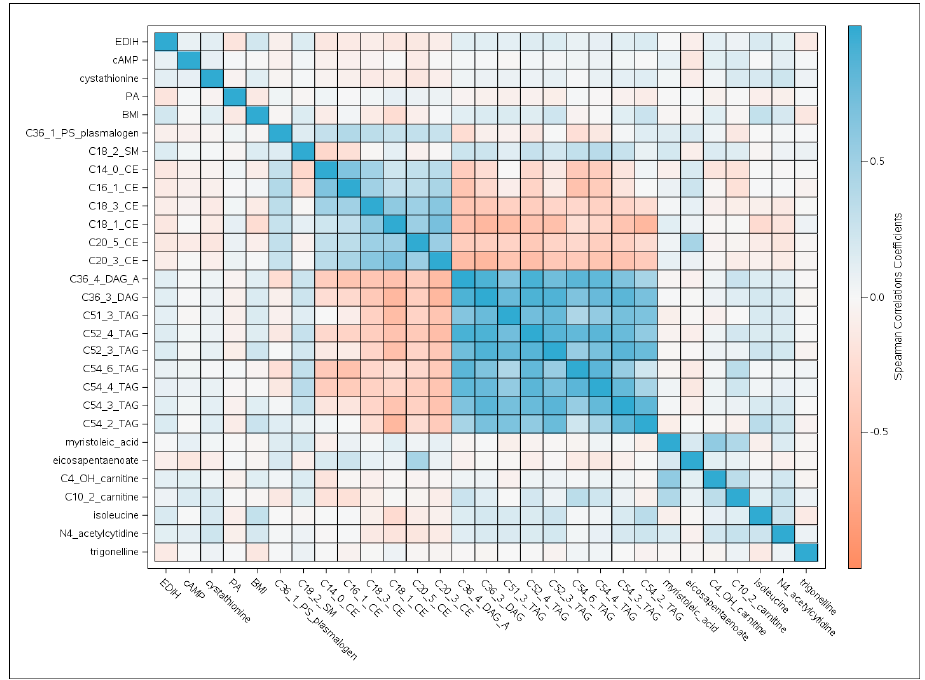
Figure 1. Heat map in the replication dataset showing Spearman correlations between the 26 discovered metabolites and EDIH score, BMI and physical activity (PA). Ordering is by hierarchical clustering. BMI, body mass index; cAMP, cyclic adenosine monophosphate; CE, cholesterol ester; DAG, diacylglycerol; EDIH, empirical dietary index for hyperinsulinemia score; PA, physical activity; TAG, triacylglycerol. 2.2.3. Among Underweight and Normal Weight Women (BMI: 15 to <25 kg/m 2 , n = 630) Among underweight ( n = 20) and normal weight ( n = 610) women, after adjustment for